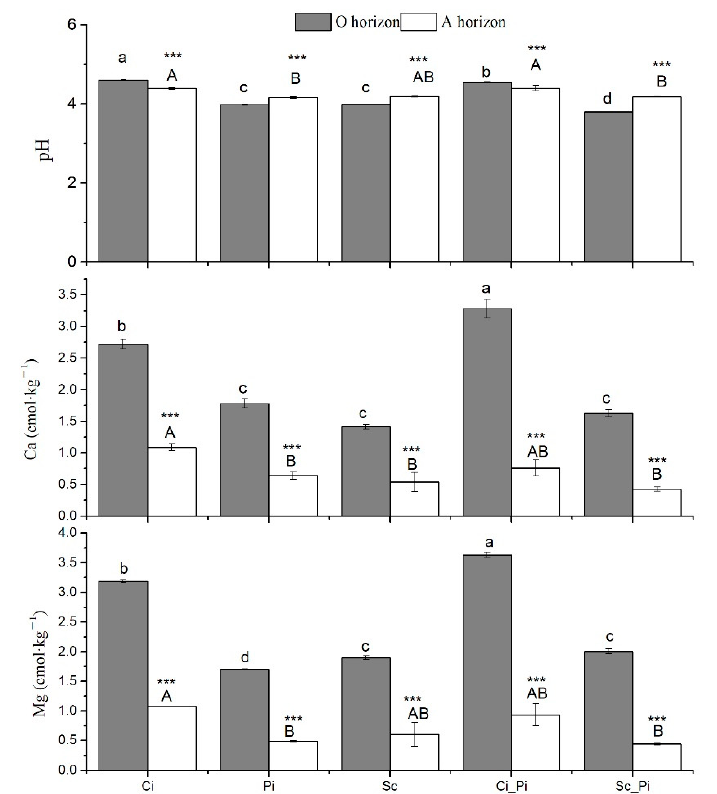
Figure 1. Soil pH and exchangeable Ca and Mg in five different forest types. Different lower case and uppercase letters indicate significant differences among forest types, respectively, for the O horizon and A horizon. *** indicates significant differences between the O and A horizon at p < 0.001.